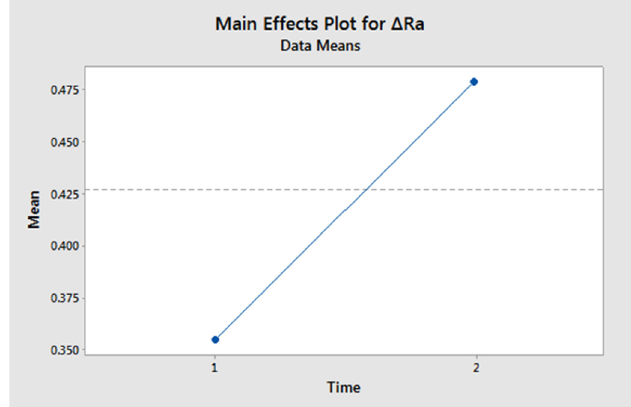
Fig. 5. Normal probability vs. residual plot.